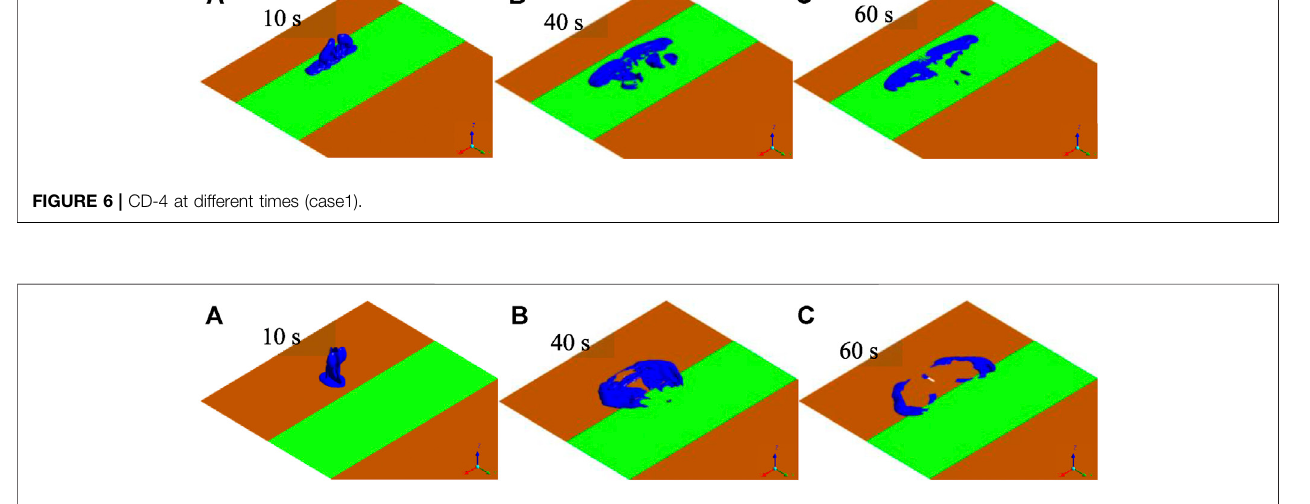
FIGURE 7 | CD-4 at different times (case2).